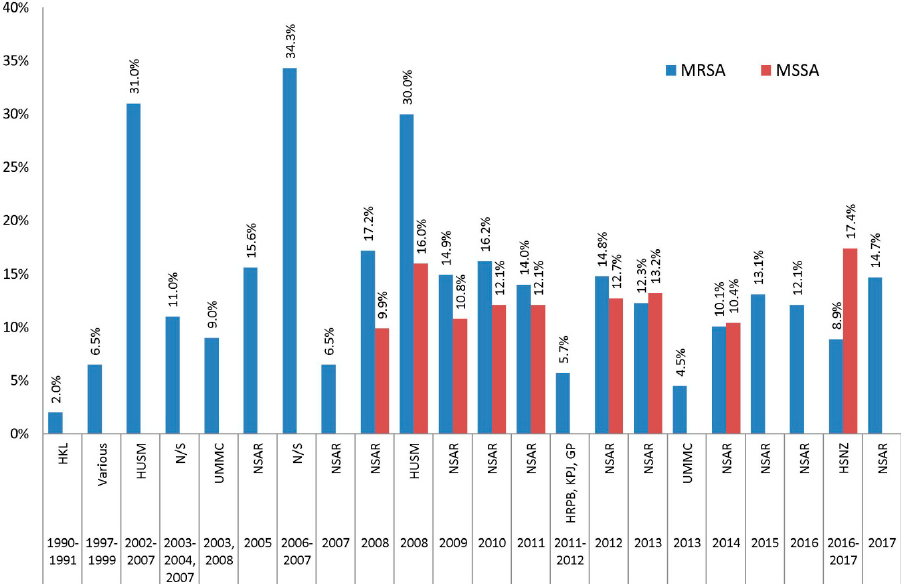
Figure 11. The prevalence of fusidic acid resistance in Malaysian S. aureus isolates, 1990–2017. Data from the NSAR reports; HKL between 1990 and 1991 [13]; various, collected from ten hospitals throughout Malaysia between 1997 and 1999 [14]; HUSM between 2002 and 2007 [15] and in 2008 [19]; not specified (N / S) between 2003 and 2004 and in 2007 [16], and between 2006 and 2007 [17]; UMMC in 2003 and 2008 [18], and in 2013 [22]; UKMMC in 2009 [20]; HRPB, KPJ and GP between 2011 and 2012 [21]; and HSNZ between 2016 and 2017